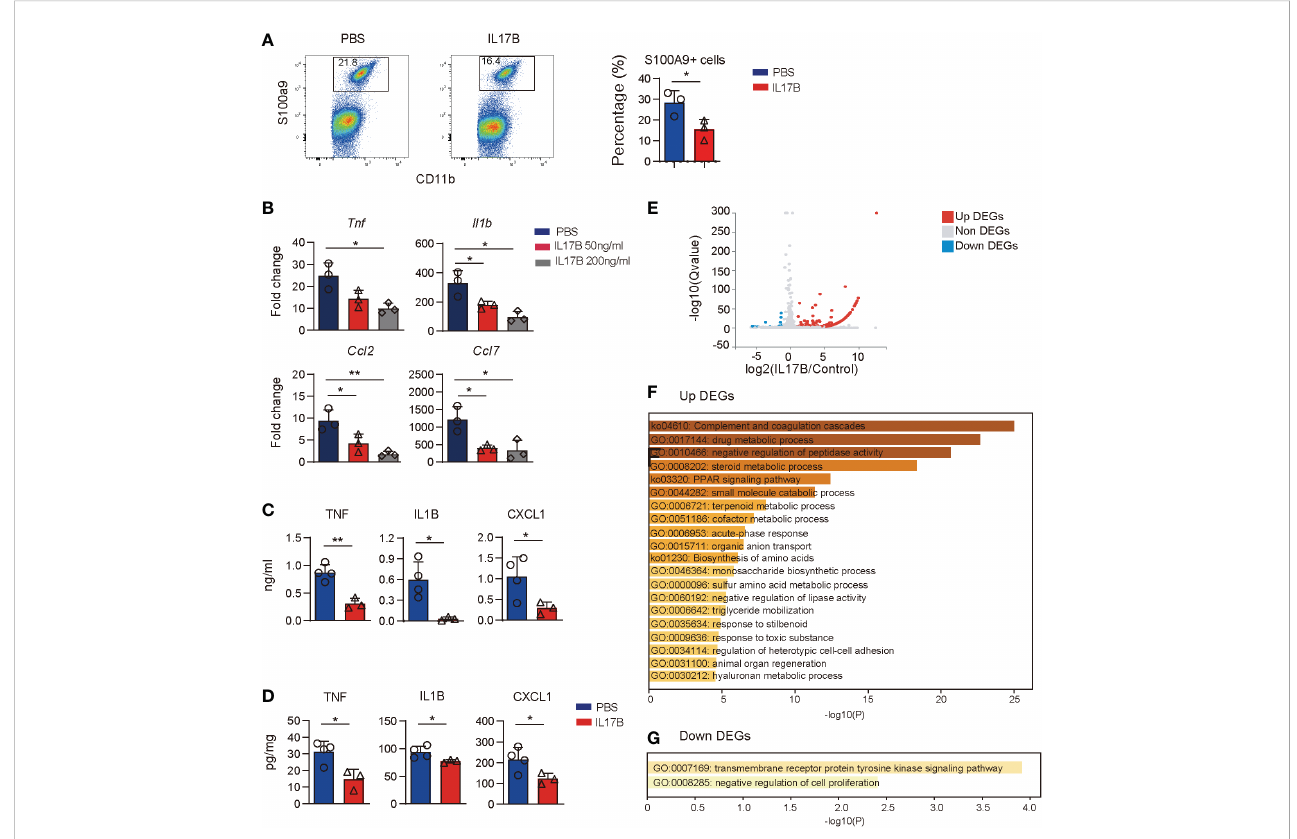
FIGURE 7 Treatment of IL17B reduces LPS-induced in fl ammation. (A) Il17b -/- mice were induced colitis and treated with IL17B as shown in fi gure 3. The in fi ltration of CD11B + S100A9 + neutrophils in colon lamina propria was detected by fl ow cytometry. Bar graph showing the statistic of the CD11B + S100A9 + cells in colitis mice. (B) BMDM was treated with LPS and IL17B for 2 hours (n = 3). The cytokines and chemokines expression of cells were detected by real-time PCR. (C, D) Mice were I.P. treated with LPS (n = 4) and IL17B (n = 3) for 2 hours and the in fl ammatory responses in serum (C) and colon tissue (D) were analyzed by ELISA. Data are mean ± SD. Statistics in (B) was done by ordinary one-way ANOVA with Turkey`s multiple comparisons test. Statistics in (C) and (D) was done with unpaired t test. * P < 0.05; ** P < 0.01. (E) Volcano plot showing the DEGs of BMDM treated with IL17B detected by bulk RNAseq (triplicate samples for each treatment). (F) Gene enrichment of upregulated DEGs of IL17B-treated BMDM. (G) Gene enrichment of downregulated DEGs of IL17B-treated